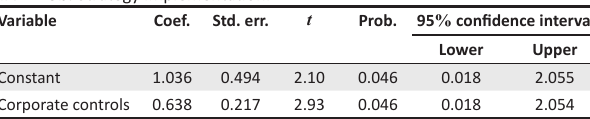
TABLE 3b: Strategy implementation.